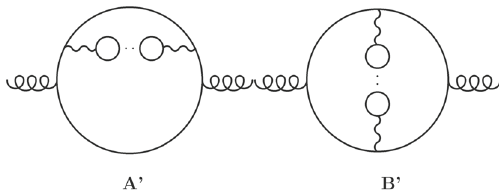
Fig. 3 Next-to-leading order diagrams for the mixed contributions, where the gauge bosons in the bubble-chain and on the external legs belong to different gauge